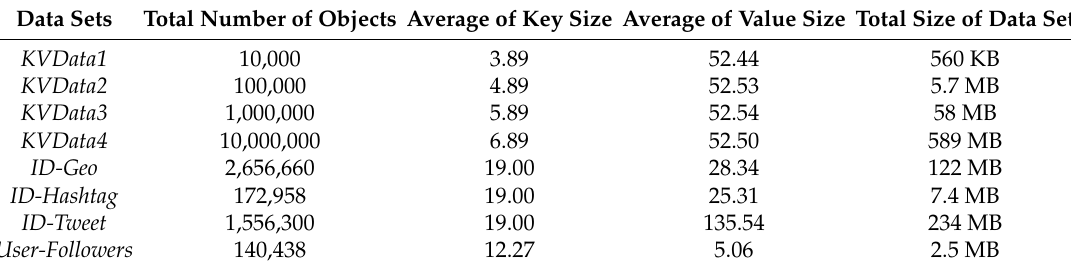
Table 4. Characteristics of the data sets.